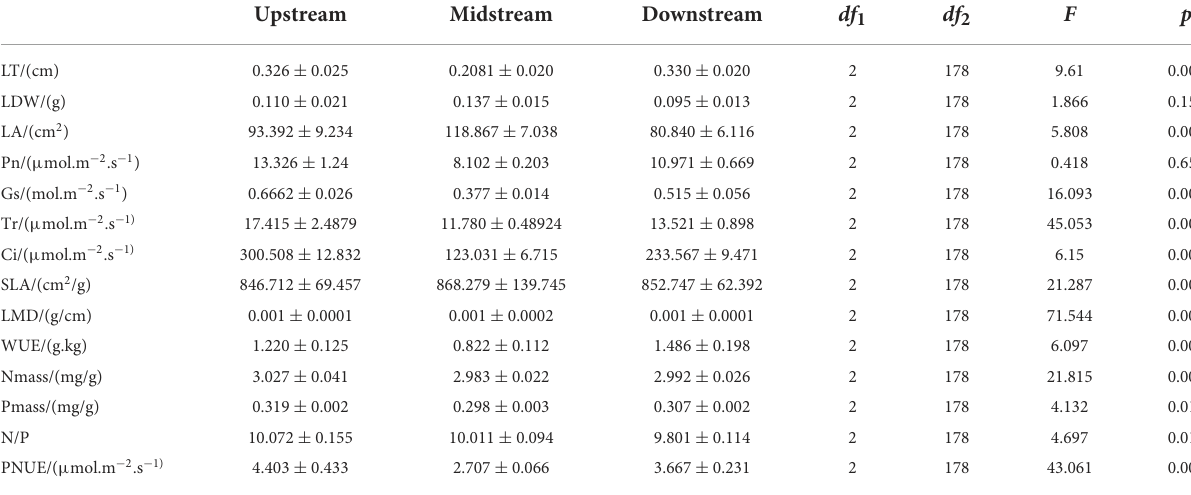
TABLE 4 Vertical comparison of leaf functional traits of dominant species in the fluctuating zone of Three Gorges Reservoir area (mean ± SE). Upstream Midstream